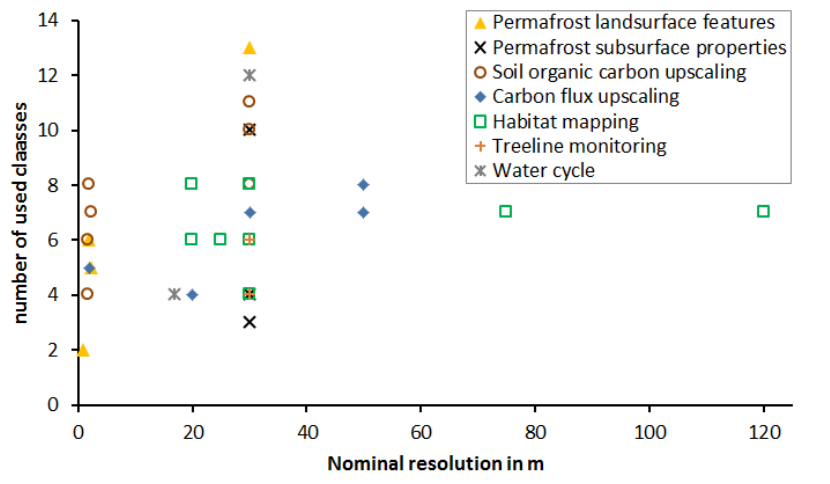
Figure 6. Comparison of the number of classes and spatial resolution from land cover classifications north of the treeline for different applications. (sources: [9,11,13,23,25,26,35,40–42,47,50,52,56,59,63,64,